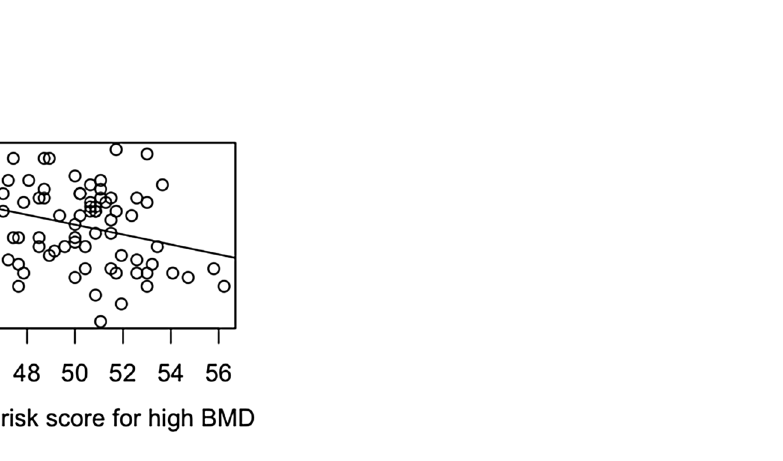
Figure 6. The genetic score for darker skin pigmentation correlates with the genetic score for low BMD levels in 74 ancient individuals belonging to the Early Neolithic and previous periods. In the horizontal axis is the genetic risk score for the BMD, and in the vertical axis is the genetic risk score for darker skin pigmentation. Each dot represents an